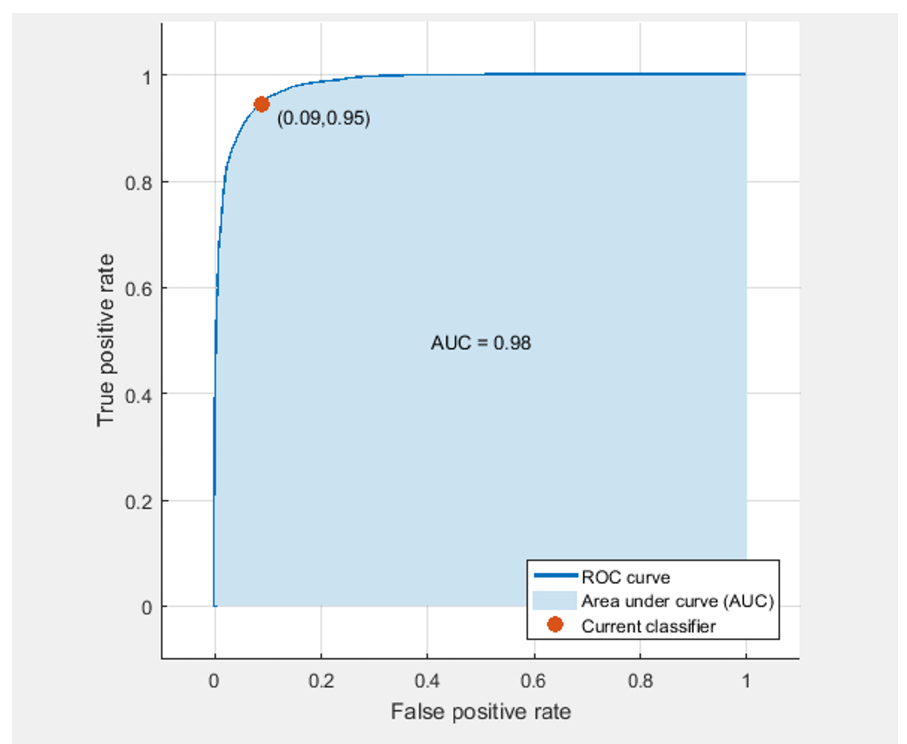
Figure 17. Receiver operating characteristic (ROC) of EMG measured from biceps brachii muscle bagged tree classifier.